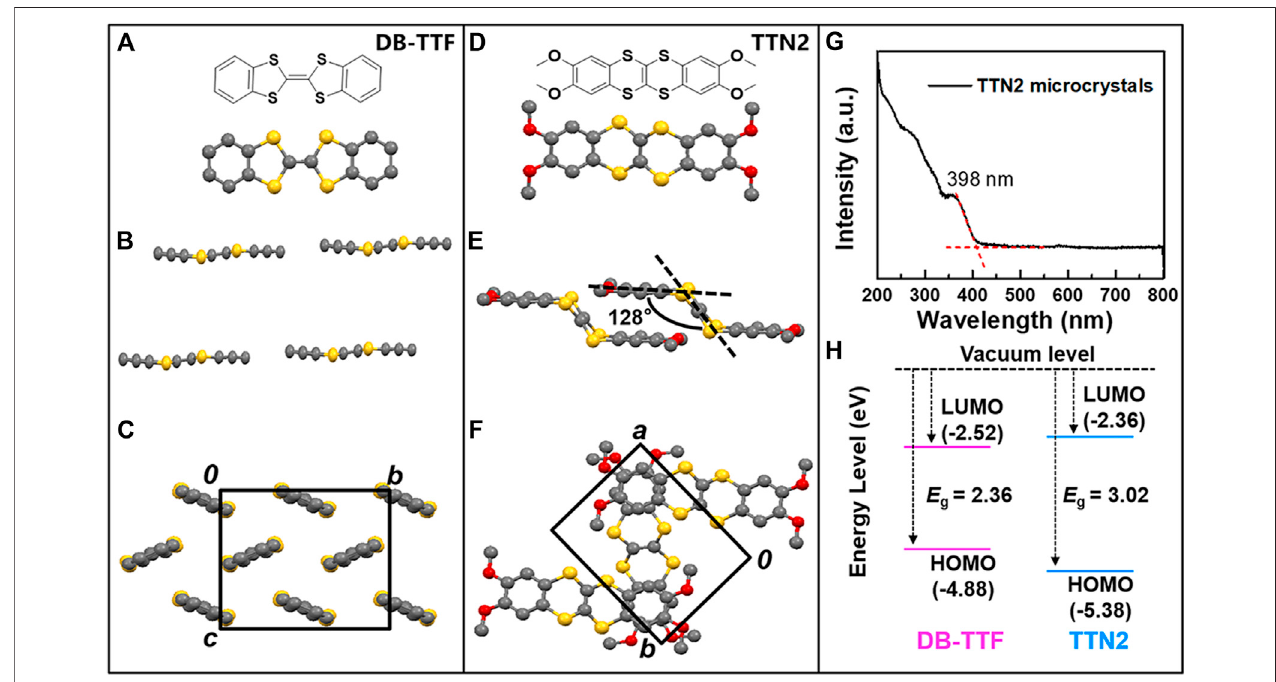
FIGURE 1 | Molecular structure and packing motifs of (A-C) DB-TTF and (D-F) TTN2 (G) UV-Vis-NIR absorption spectra of TTN2 microcrystals (H) Energy levels and bandgaps of DB-TTF and TTN2.